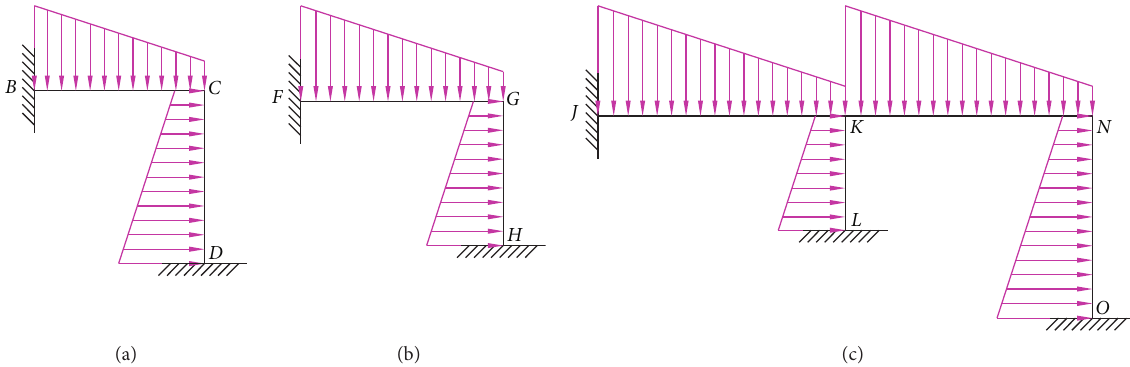
Figure 4: Simplified figure of the load effects of the ASCL above the slip surfaces: (a) simplified figure of the load effects of BCD; (b) simplified figure of the load effects of FGH; (c) simplified figure of the load effects of JKLNO.